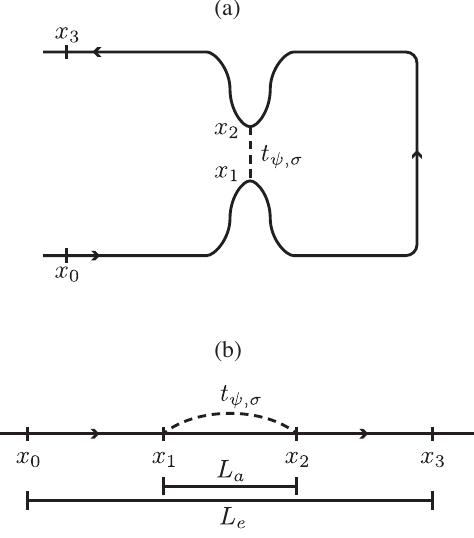
FIG. 17. (a) Geometry and coordinates used to explicitly analyze the emergent-fermion transmission amplitude in the interferometer from Fig. 10. Appendixes C and D, respectively, treat the cases where only fermions tunnel (with coupling t ψ ) and only Ising anyons tunnel (with coupling t σ ) across the constric- tion. (b) Unfolded version of (a), not to scale. In terms of lengths shown in Fig. 10(a), we have x 2 − x 1 ¼ L and x 3 − x 0 ¼ L a e